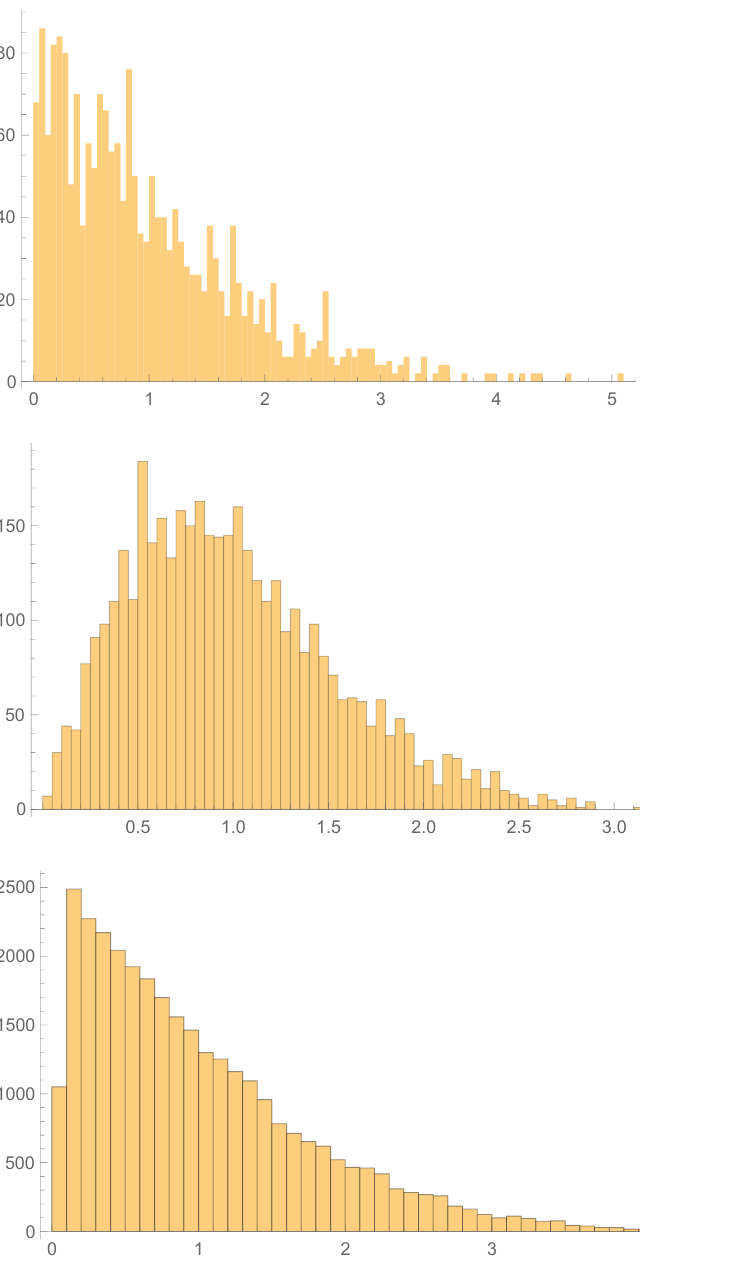
Figure 8 . The unfolded level spacing distribution for the generalized model. Top: N = 24, center: N = 28, bottom: N =